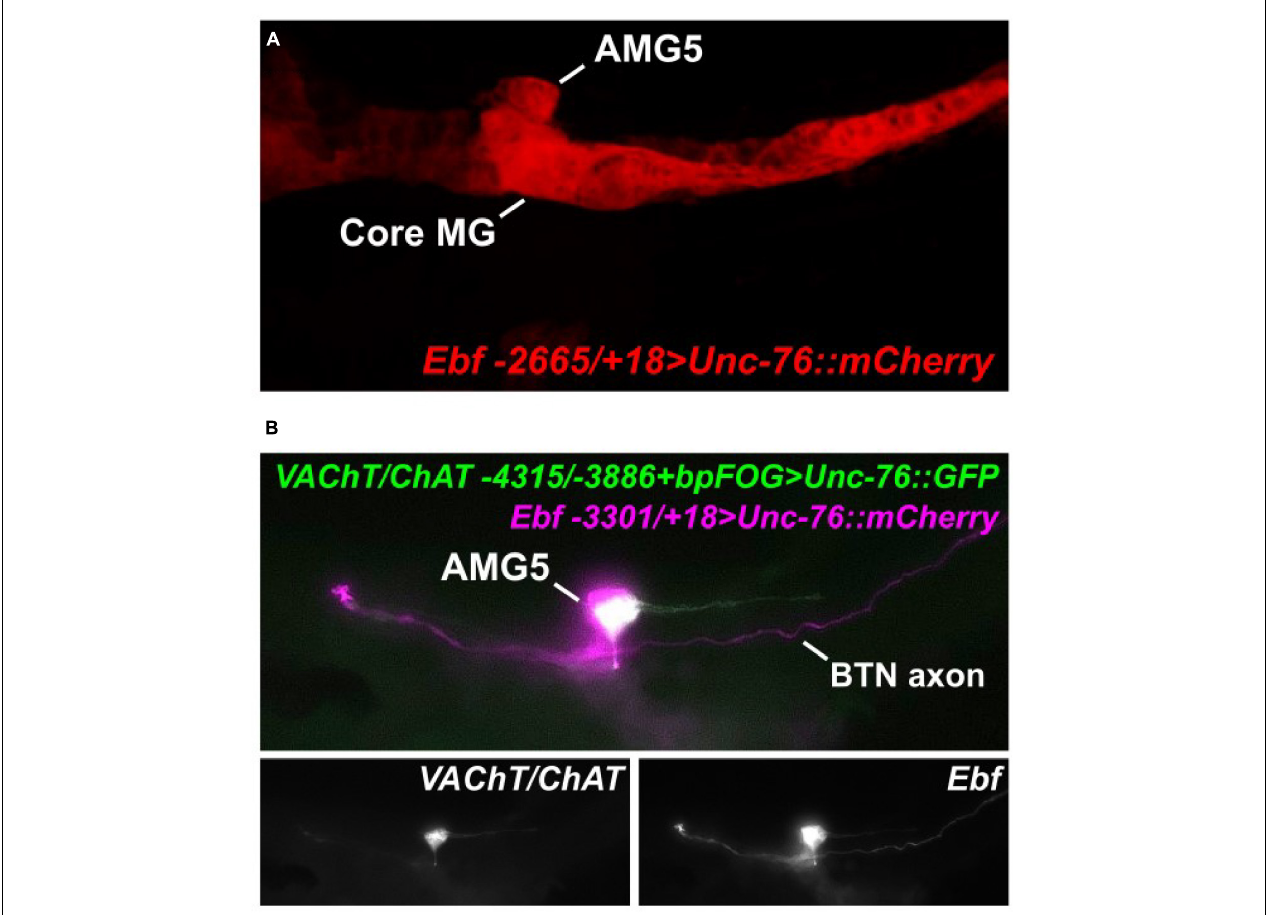
FIGURE 2 | AMG5 co-expresses VAChT/ChAT and Ebf. (A) An Ebf reporter plasmid labels various CNS neurons including AMG5 at 18 h post-fertilization (hpf) at 20 ◦ C. Image is a confocal Z stack projection. (B) Co-electroporation of the Ebf reporter and the minimal AMG5-specific VAChT/ChAT reporter revealed co-expression in AMG5 at 17 hpf, 20 ◦ C. In this example, the larva shows mosaic incorporation of the plasmids only in the animal pole-derived lineages, which give rise to AMG5 and the Bipolar Tail Neuron (BTN) that also expresses Ebf (Stolfi et al., 2015), but not the core MG.